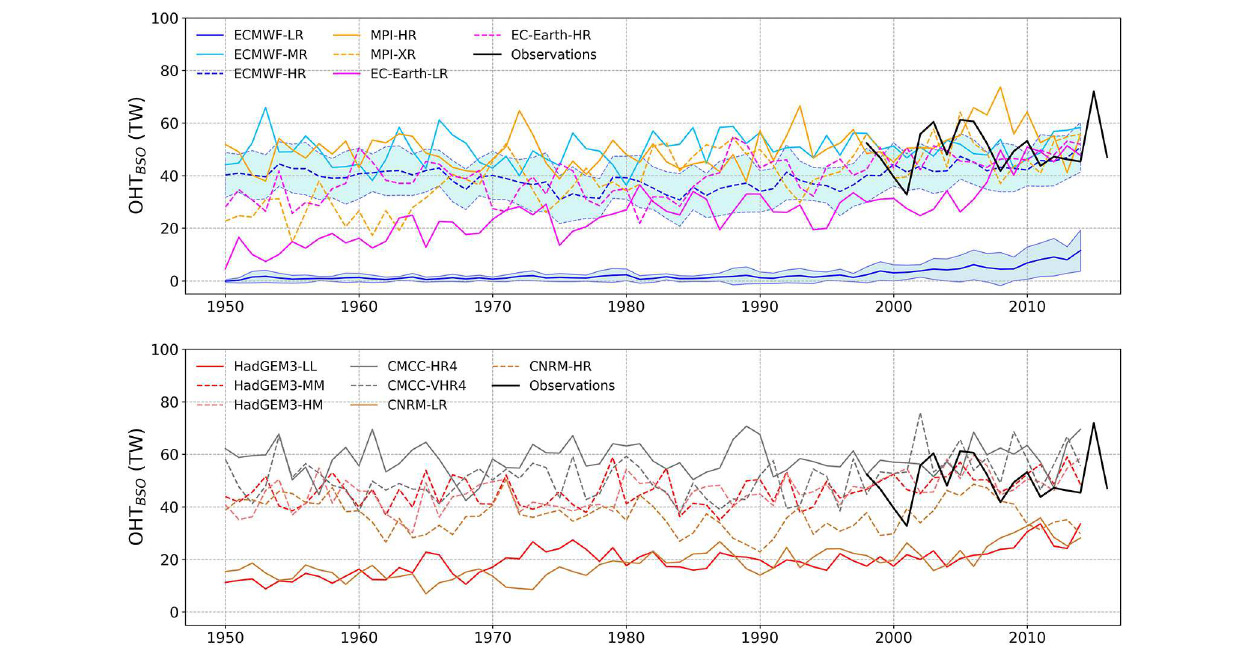
FIGURE 3 | Time series of annual mean ocean heat transport (OHT) at the Barents Sea Opening (BSO, reduced transect, 20 ◦ E, 71.5–73.5 ◦ N) over 1950–2014 using HighResMIP hist-1950 model outputs (split in two different panels for readability) and IMR observations. The blue shadings of ECMWF-LR and ECMWF-HR represent the ensemble standard deviation (six members for